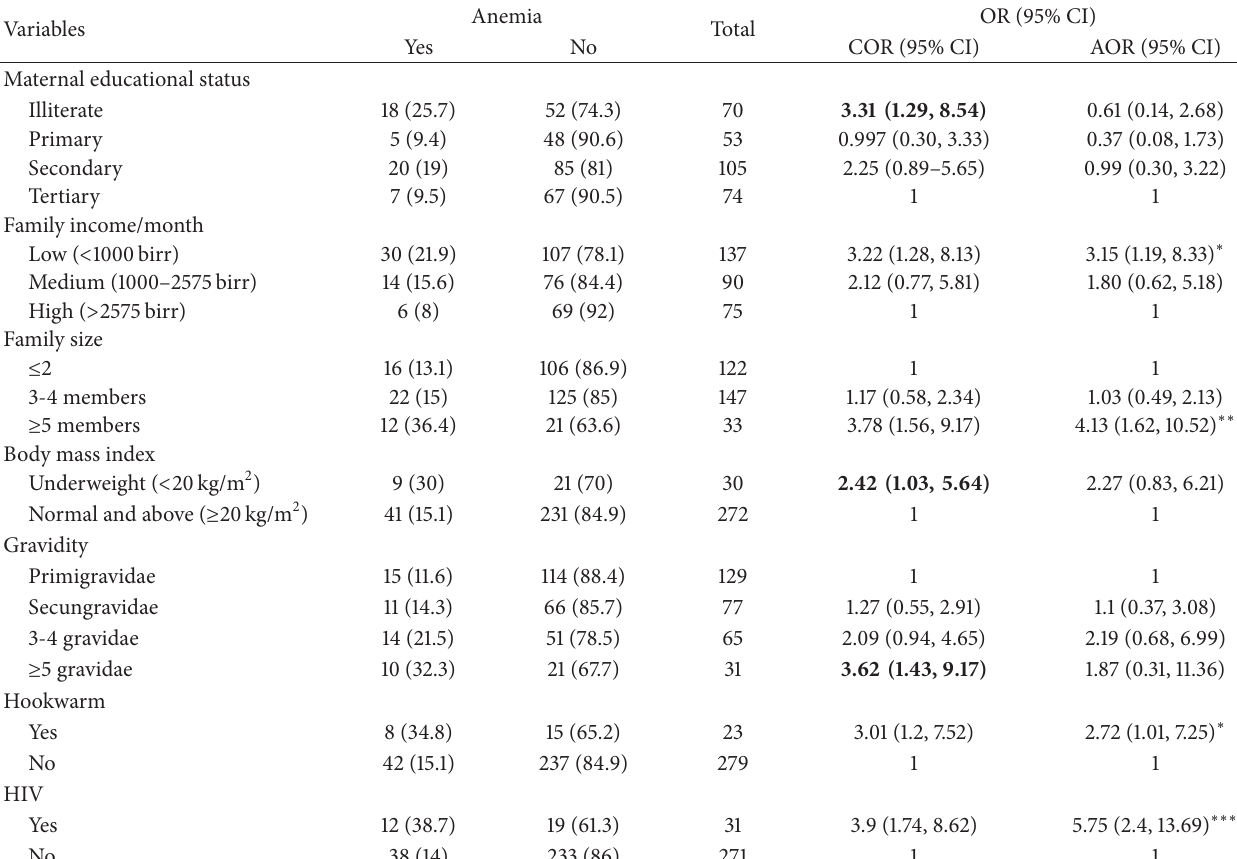
Table 5: Multivariate binary logistic regression analysis of pregnancy anemia with predictor variables ( 𝑛 = 302